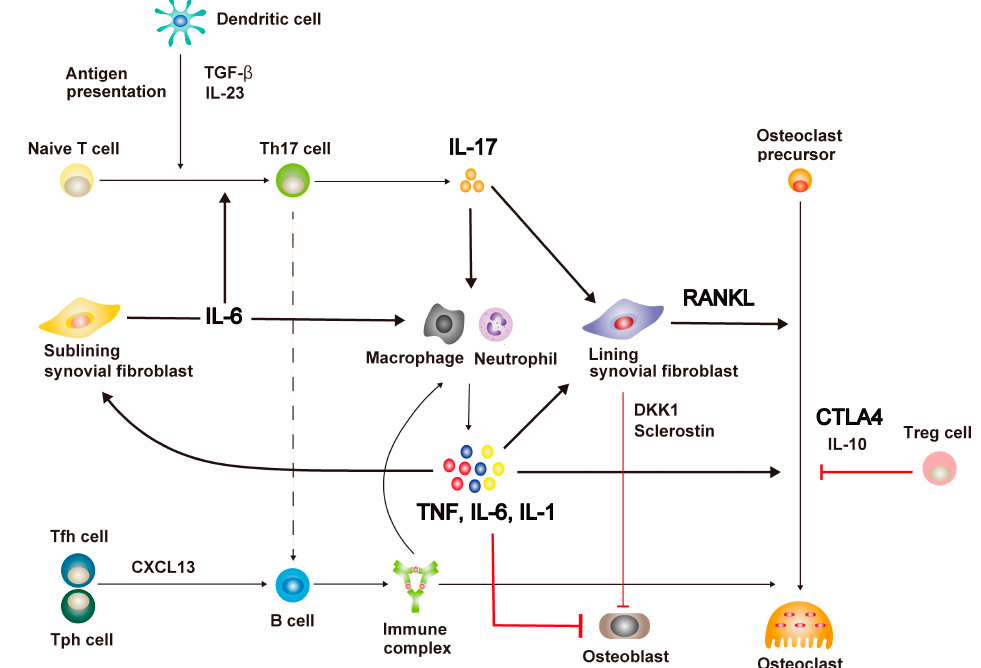
Figure 1. The pathway of inflammation and bone destruction in rheumatoid arthritis and the mechanism of action of biological agents. In rheumatoid arthritis (RA) synovium, antigen-presenting cells (APCs), including dendritic cells, present self-antigens and produce transforming growth factor- β (TGF- β ) and interleukin-23 (IL-23), which promote T helper 17 cell (Th17) differentiation and IL-17 secretion. IL-17 stimulates the production of pro-inflammatory cytokines, such as tumor necrosis factor (TNF), IL-6, and IL-1, by synovial macrophages and neutrophils, and induces receptor activator of NF- κ B ligand (RANKL) expression in lining synovial fibroblasts. Pro-inflammatory cytokines further promote IL-6 production by the sub-lining synovial fibroblasts and RANKL expression in the lining of synovial fibroblasts and activate the osteoclast differentiation pathway. Immune complexes produced by B cells, upon stimulation of chemokine (C-X-C motif) ligand 13 (CXCL13) from T follicular helper (Tfh) and T peripheral helper (Tph) cells, boost local inflammation and osteoclast differentiation. Dickkopf-related protein 1 (DKK1) and sclerostin, produced by the lining synovial fibroblasts, and pro-inflammatory cytokines inhibit osteoblast differentiation. Anti-IL-17 antibodies suppress inflam- mation and bone destruction. Anti-TNF antibodies and anti-IL-1 antibodies inhibit inflammation and bone destruction, simultaneously improving bone repair capacity. Anti-IL-6 antibodies restrain in- flammation, bone destruction, and Th17 cell differentiation besides contributing to the improvement in bone repair capability. CTLA4 immunoglobulin prevents osteoclast differentiation. Anti-RANKL antibody directly inhibits bone